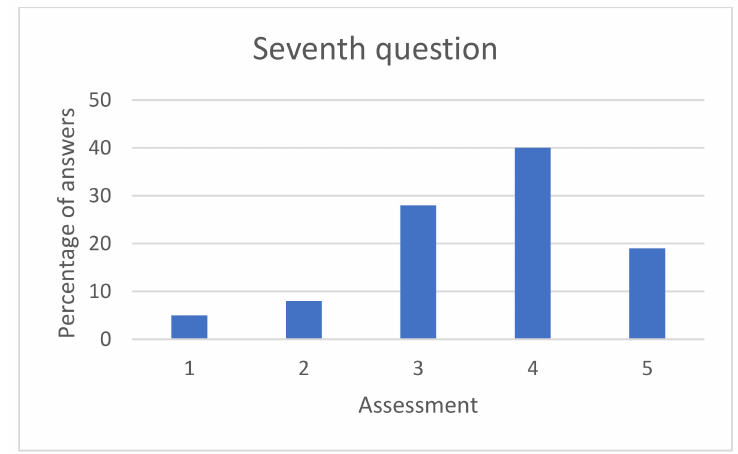
Figure A8. Results of question 7.